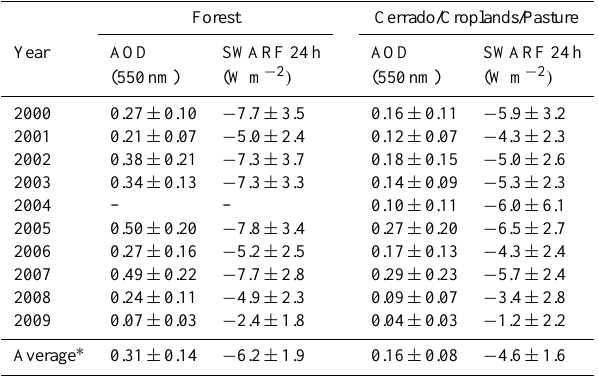
Deforested regions tend to be drier than forested regions,